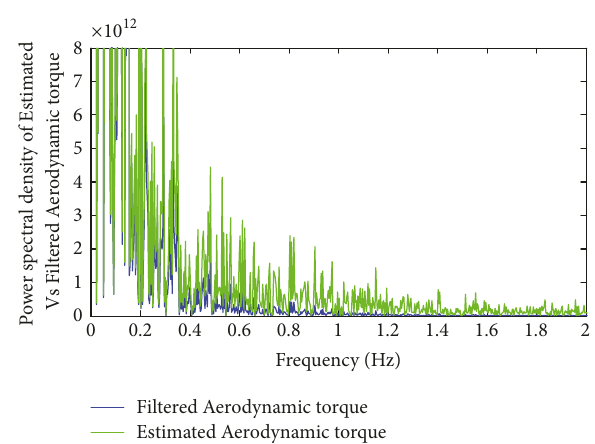
Figure 6: The power spectral density of the estimated and filtered aerodynamic